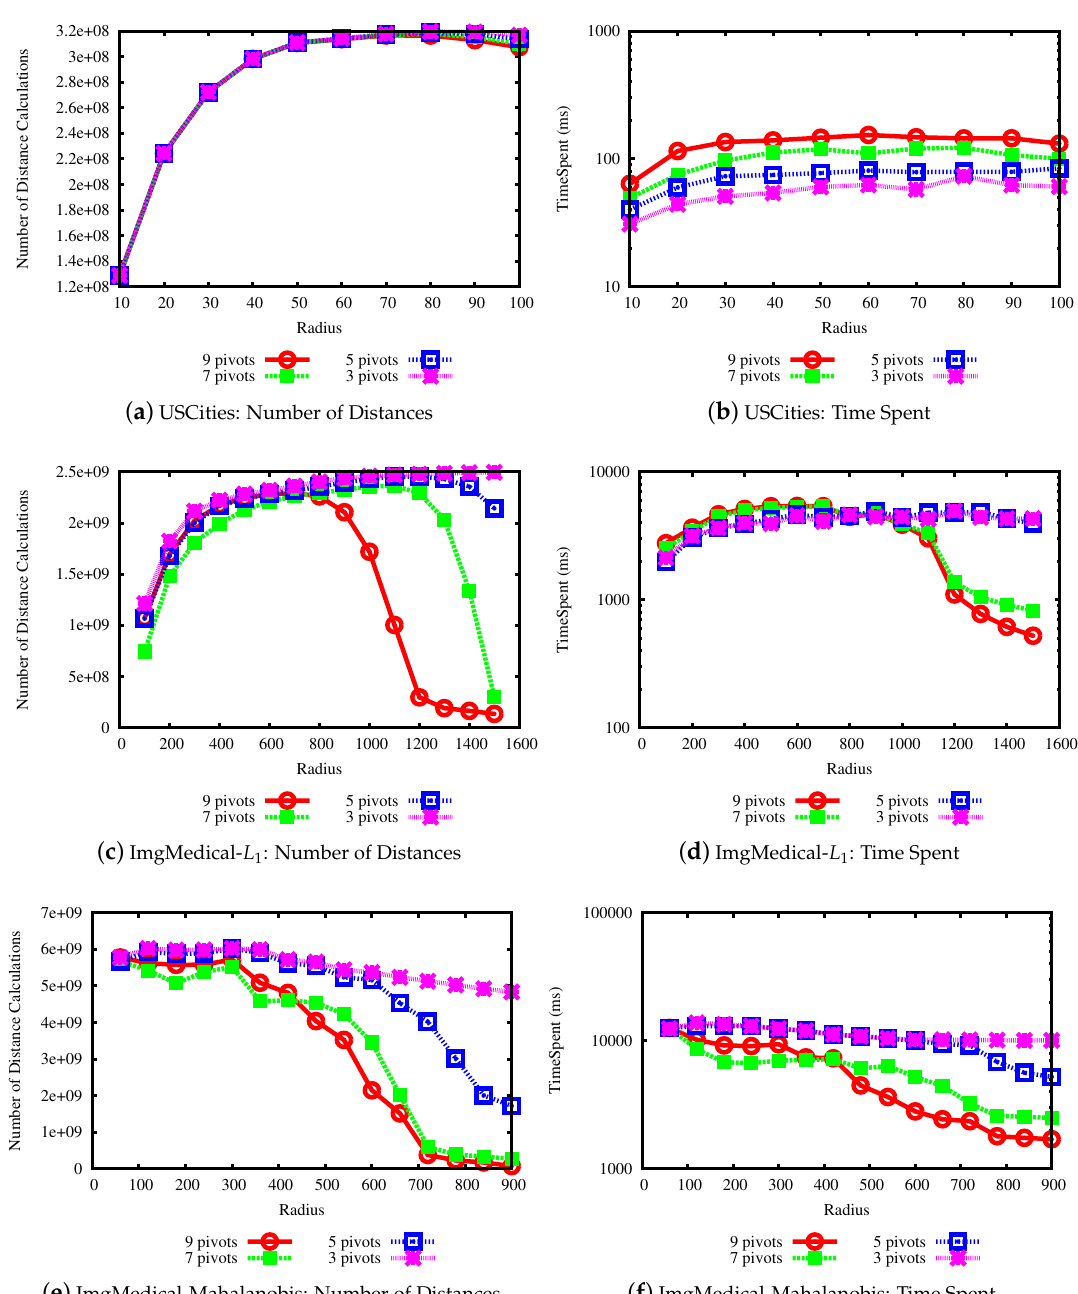
Figure 12. Performance of similarity joins for LUBJOIN varying the number of pivots. ( a , c , e ) the average of the number of distances calculated in queries. ( b , d , f ) the time spent for performing the queries